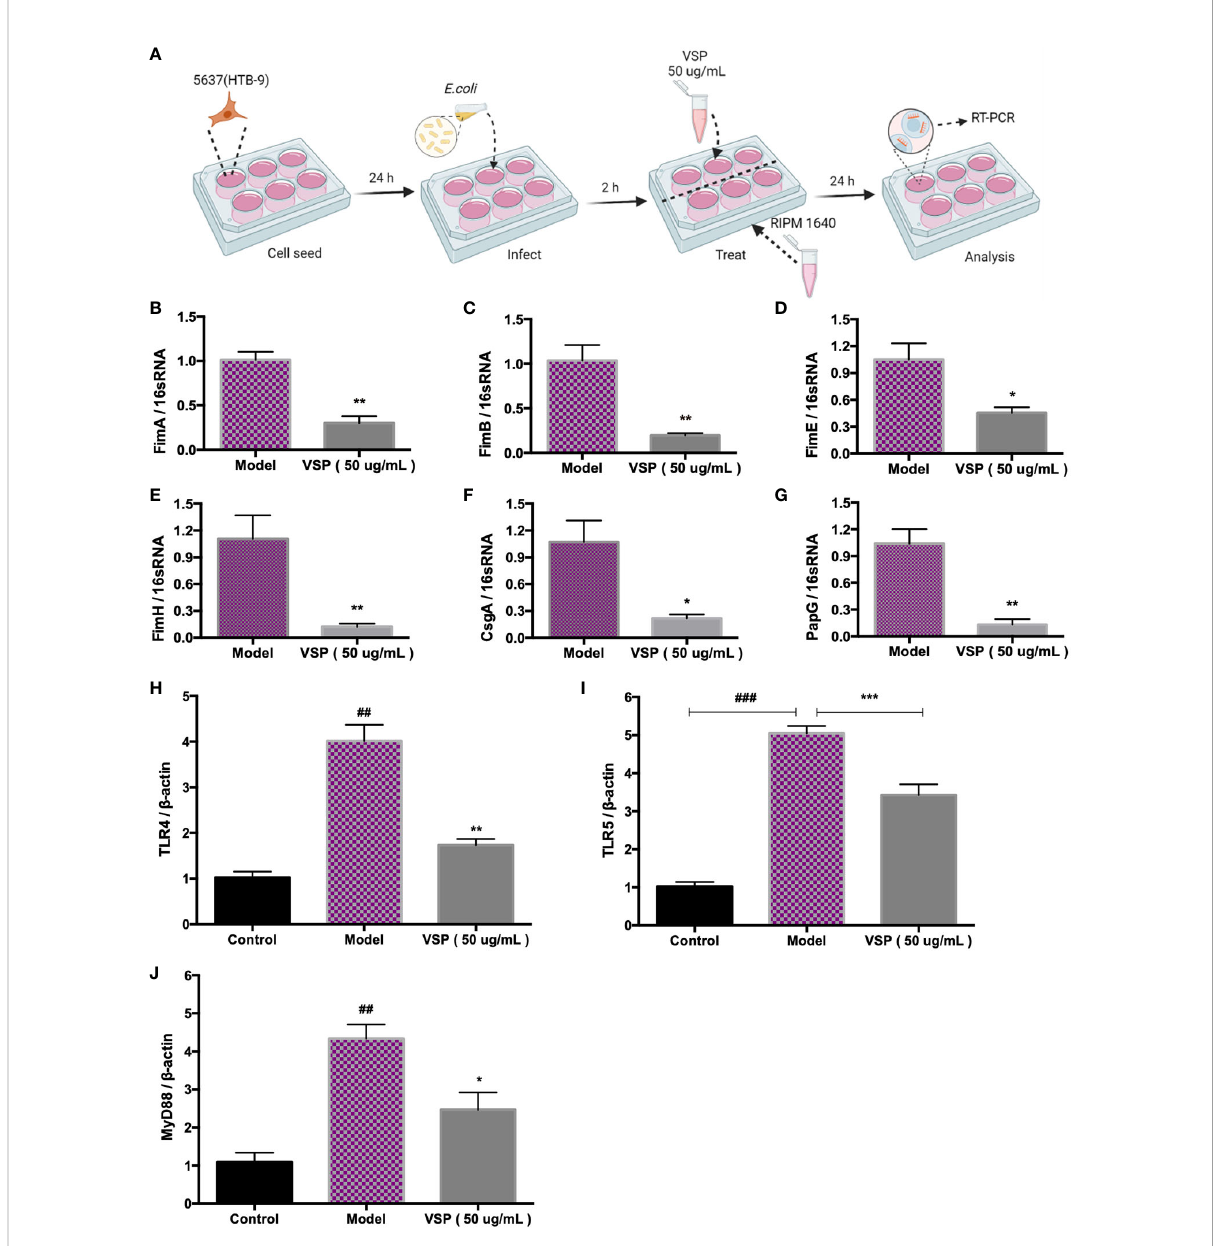
FIGURE 3 VSP inhibited the adhesion of UPEC CFT073. (A) , A scheme of the E. coli infection and VSP administration. (B-G) , The relative transcript levels of UPEC CFT073 adhesion fi bronectin FimA, FimB, FimE, FimH, CsgA, and PapG after VPS intervention, were assessed by RT-PCR with 16S RNA as the internal control. (H-J) , The relative transcript levels of TLR4, TLR5 and MyD88 in 5637 (HTB-9) cells after the VPS intervention, were assessed by RT-PCR with b -actin as the internal control. n =4, compared with the control group: ## p < 0.01. Compared with the model group: * p < 0.05, ** p < 0.01, the results were determined by one-way ANOVA followed by Dunnett ’ s post hoc test. ### p < 0.001, *** p <